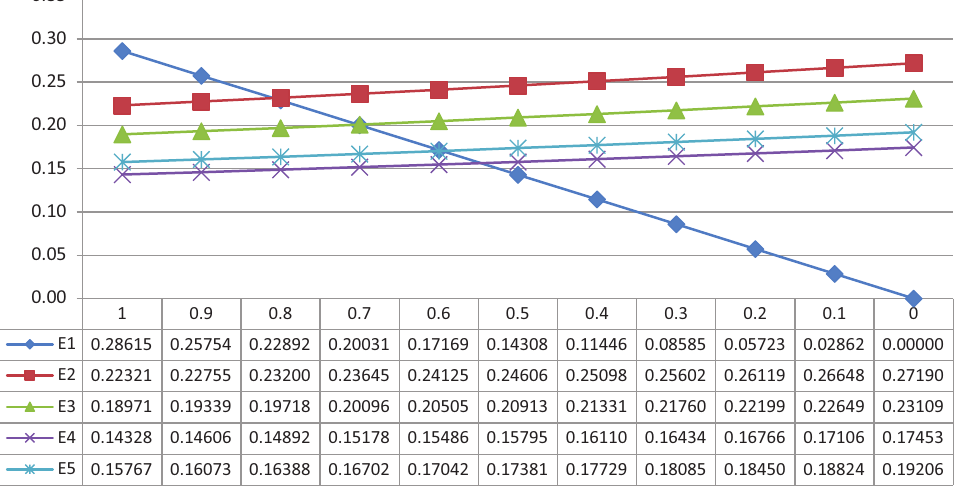
Figure 8. Results of the sensitivity analysis for the factor Smart Infrastructure